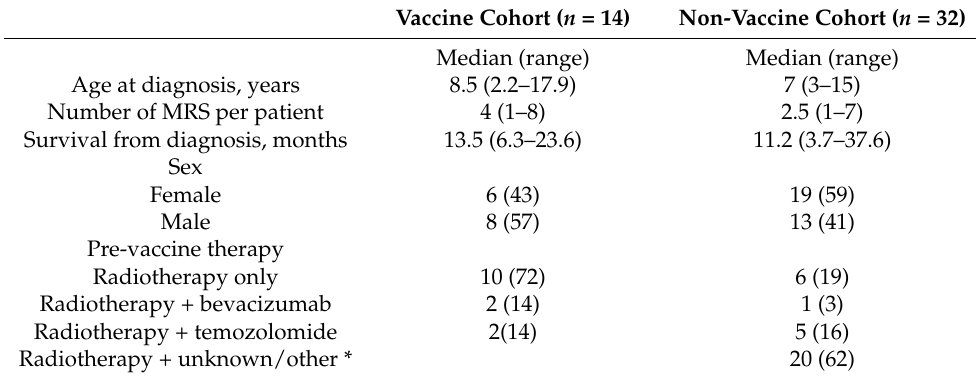
Table 1. Patient